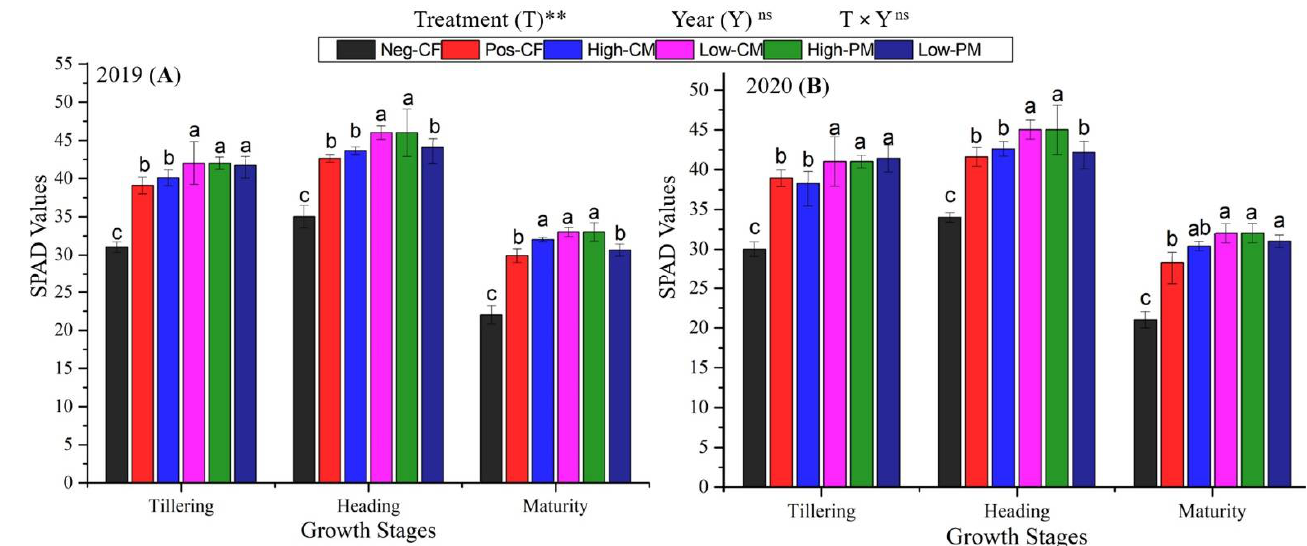
Figure 5. Changes in the leaf SPAD values in the year 2019 ( A ) and 2020 ( B ) as affected by integrated manure and chemical N fertilizer application. Means sharing the same letter within a category are not significantly different according to Tukey’s HSD test at p < 0.05. **, * = significant at 5% and 1%, respectively; ns = non-significant. Note: Please see Figure 2 for the treatment combinations.